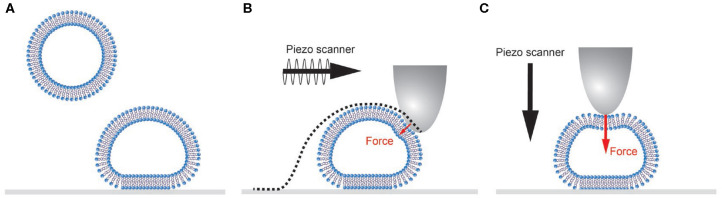
Schematic representation of single vesicle AFM experiments. (A) Vesicles adhere and subsequently deform onto a surface. (B) During AFM imaging the tip is scanned over the sample. In force distance-based imaging the cantilever is oscillated below its resonance frequency, and the force exerted on the sample is well controlled. Small forces will still result in non-negligible sample deformation. The recorded AFM image is always a convolution of the vesicle and tip shape (dotted line). (C) During a nanoindentation experiment the cantilever is lowered onto the center of the vesicle applying a higher force set point (typically 0.5–10 nN) than during imaging.